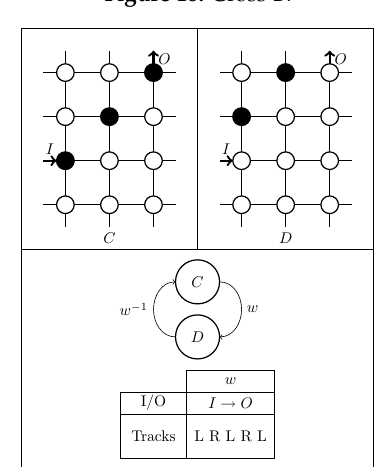
Figure 18. Cross B.